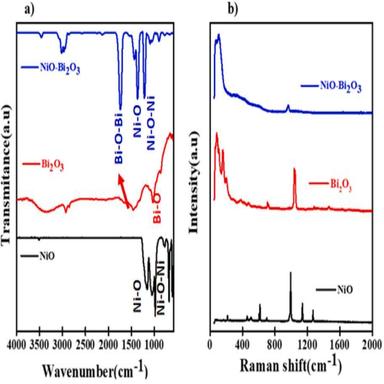
a) IR spectra and b) Raman spectra of pure NiO, Bi2O3 and NBO composite materials.